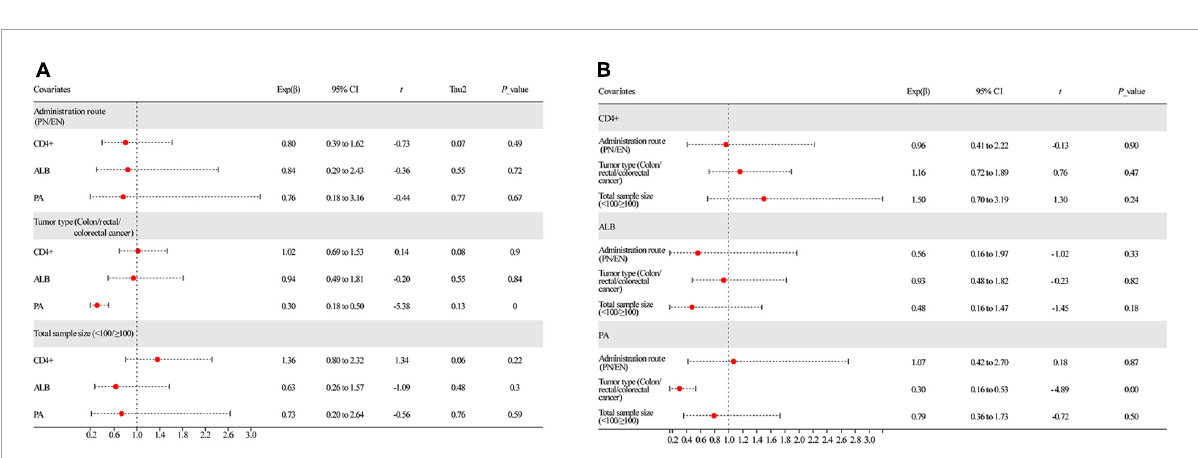
FIGURE9 Results of meta-regression analysis. (A) Univariate analysis of all covariates and (B) multivariate analysis of all covariates. ALB, albumin; PA, prealbumin.